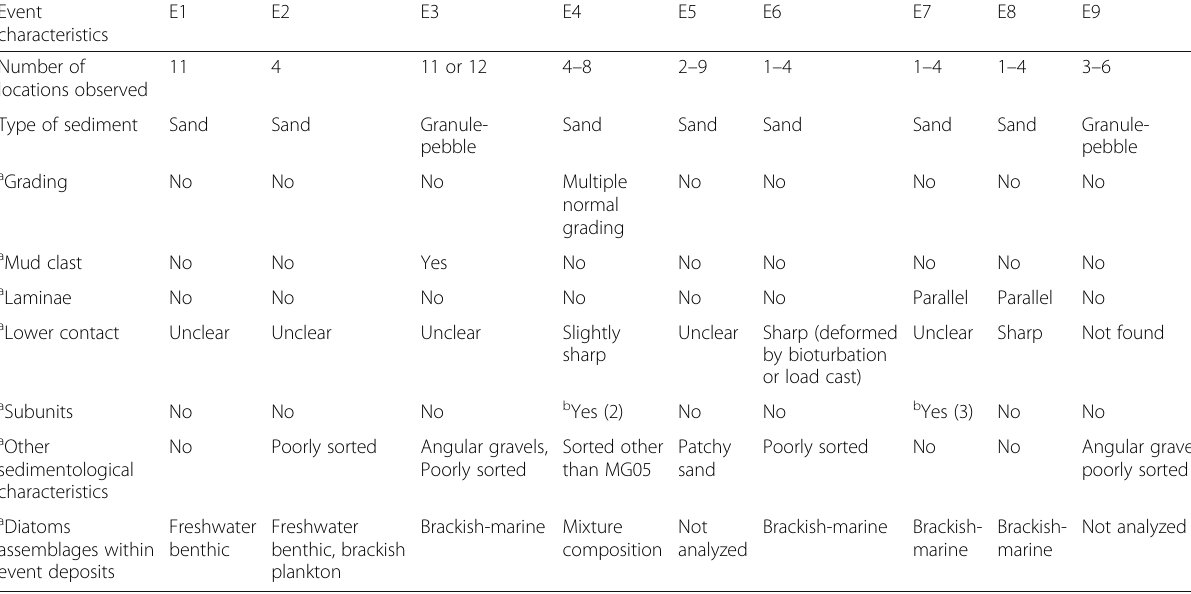
Table 4 Characteristics of event deposits at Mugi Town Event